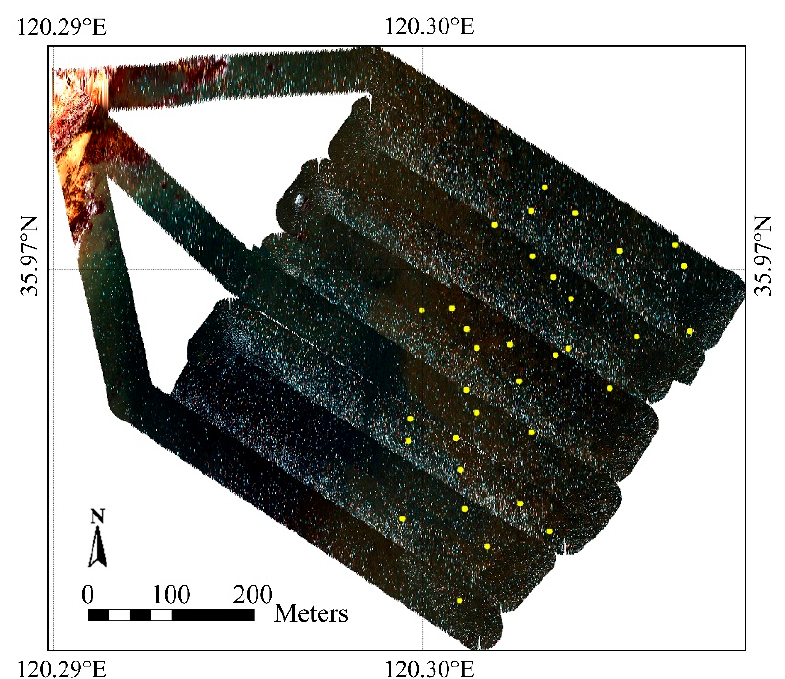
Figure 4. Location of the spectrum sampling sites. The yellow dots are the sites for spectrum collection by QE Pro on 22 March 2019.